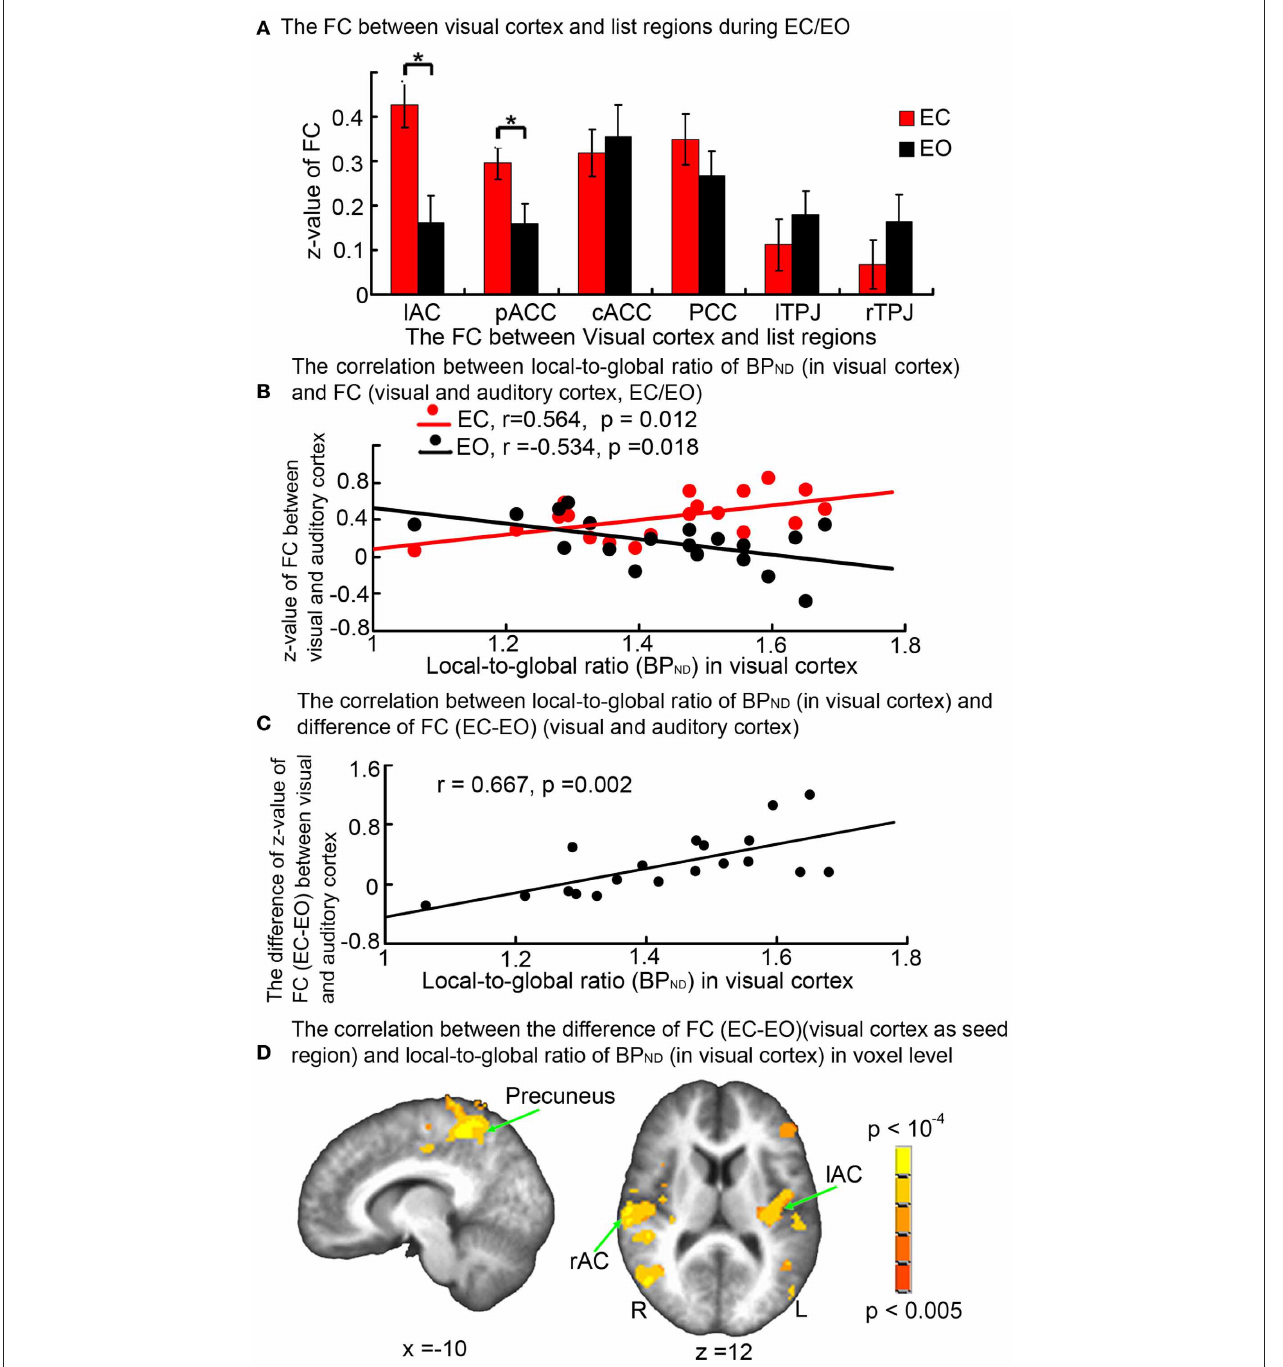
p = 0 . 012 uncorrected); in contrast, during EO, the relationship becomes negative ( r = − 0 . 534, p = 0 . 018 uncorrected). (C) Difference (EC-EO) in FC between the visual and the auditory cortex was significantly correlated with local-to-global ratio of GABA A receptor BP ND in the visual cortex [ r = 0 . 667, p = 0 . 002 ( p < 0 . 05, with Bonferroni correction)]. (D) Voxel-wise regression of local-to-global ratio of GABA A receptor BP ND in the visual cortex ROI against whole-brain FC Z -value difference (EC-EO) (visual cortex ROI as seed region); significant clusters in bilateral auditory cortex are shown ( p < 0 . 05, FWE